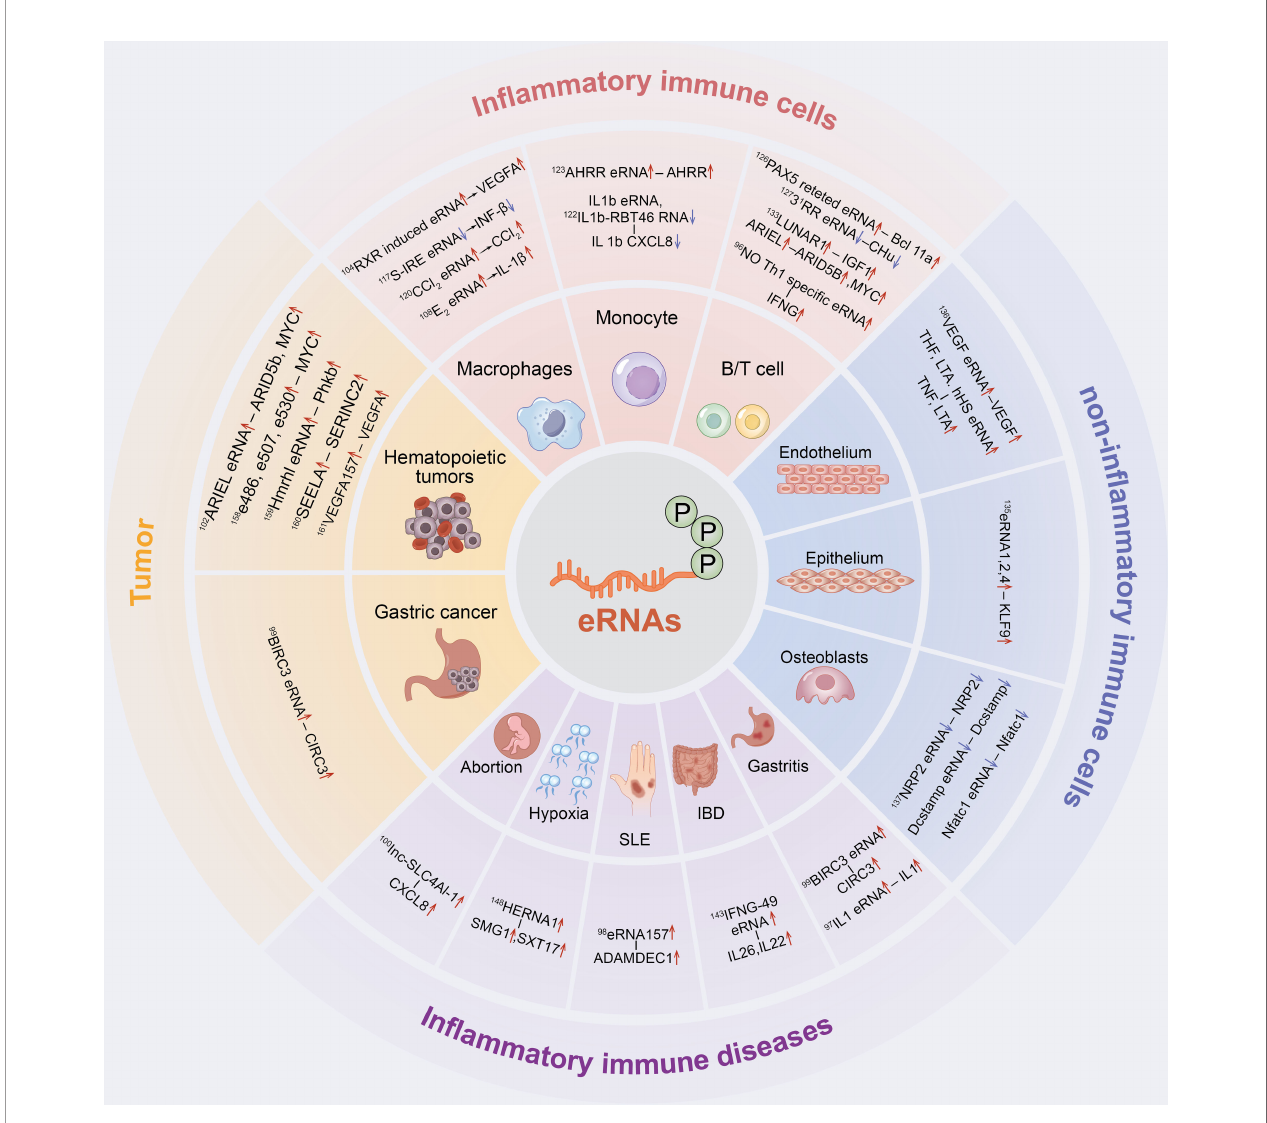
FIGURE 2 | The in fl ammatory immune role of eRNAs in cells and diseases. eRNAs have a signi fi cant contribution in in fl ammatory immune cells, non-in fl ammatory immune cells, in fl ammatory immune diseases and tumor in fl ammatory